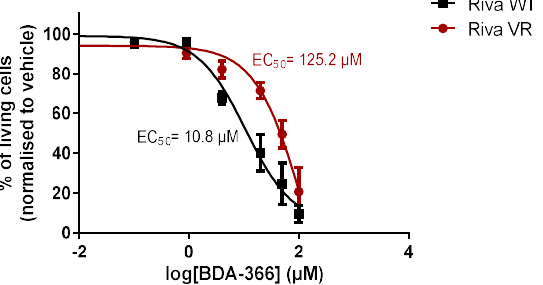
Figure 6. Venetoclax resistance induces cross-resistance towards BDA-366. Dose–response curves of Riva WT and Riva VR after incubation with BDA-366 for 24 h. The apoptotic population was defined as the AnnexinV-FITC-positive fraction. Data represented as average ± SEM ( n = 4).